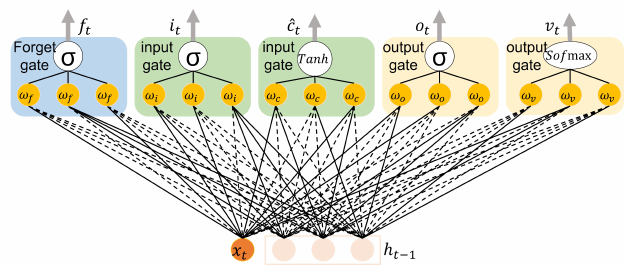
Figure 5. Random topology formation of